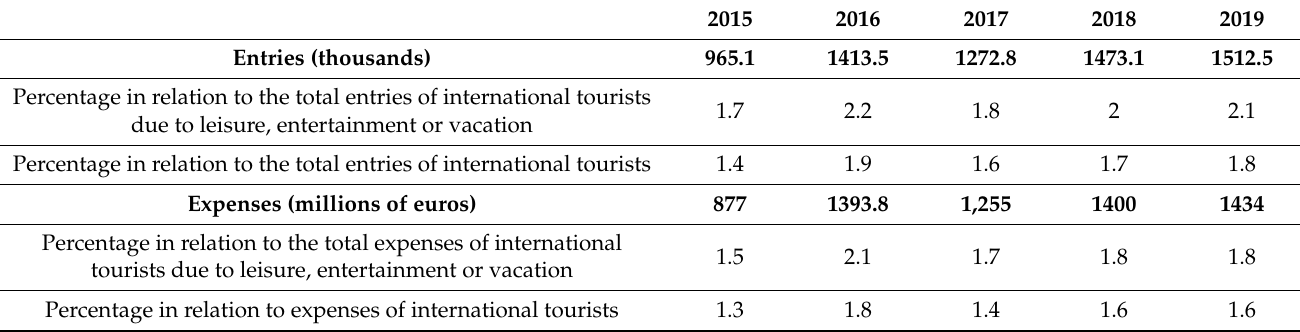
Table 6. Entries and total expenses of international tourists due to reasons related to